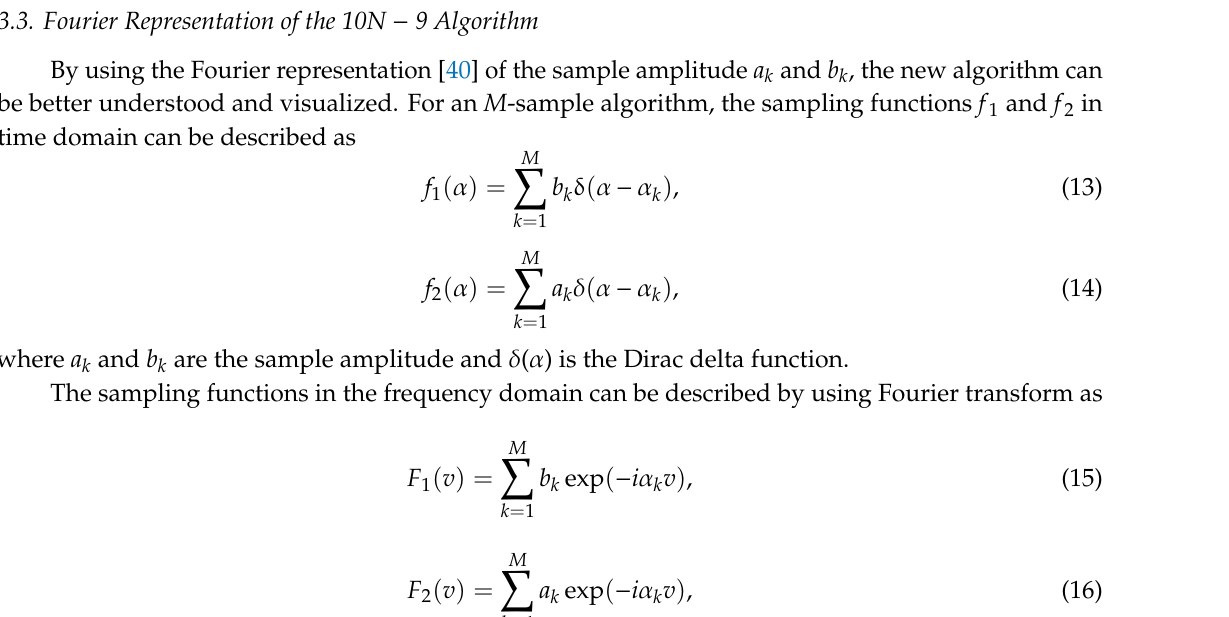
Figure 4. Shape of polynomial window function.